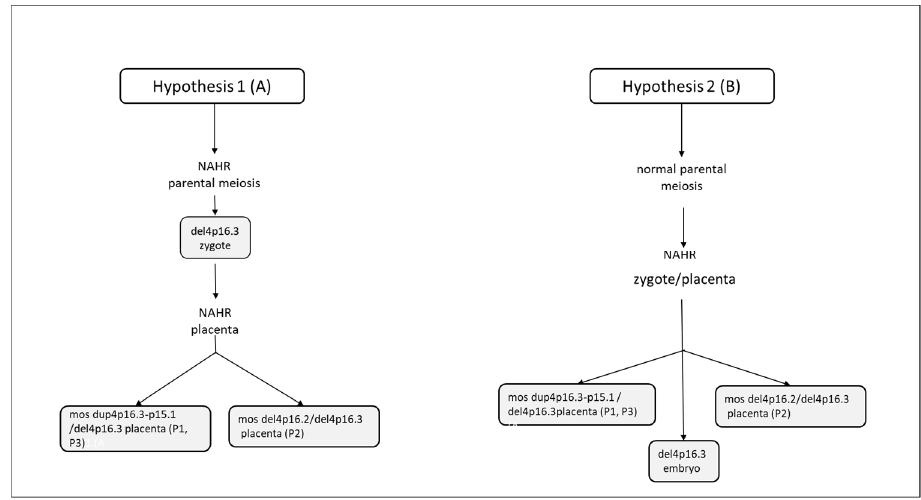
Figure 5. Schematic chart to explain the mosaic formation. ( A ) Initial formation of a zygote with del 4p16.3 deletion, originating during the parental gametogenesis; later, in the stages of embryonic development, the other genomic rearrangements observed in samples 1, 2 and 3 of the placenta (dup(4p16.3 − p15.1 and del(4p16.2), due to non-allelic homologous recombination (NAHR) and, subsequent to a mitotic non-disjunction, would have originated in and been confined to the pla- centa. ( B ) Initial formation of a zygote 46,XY, originating during parental meiotic events. Then, during the mitotic events of embryonic development, the del4p16.3, in the embryo, mos dup4p16.3- 15.1/del4p16.3 (placenta P1 eP3) and mos del4p16.2/del4p16.3 (placenta P2) in the placenta were observed, due to non-allelic homologous recombination